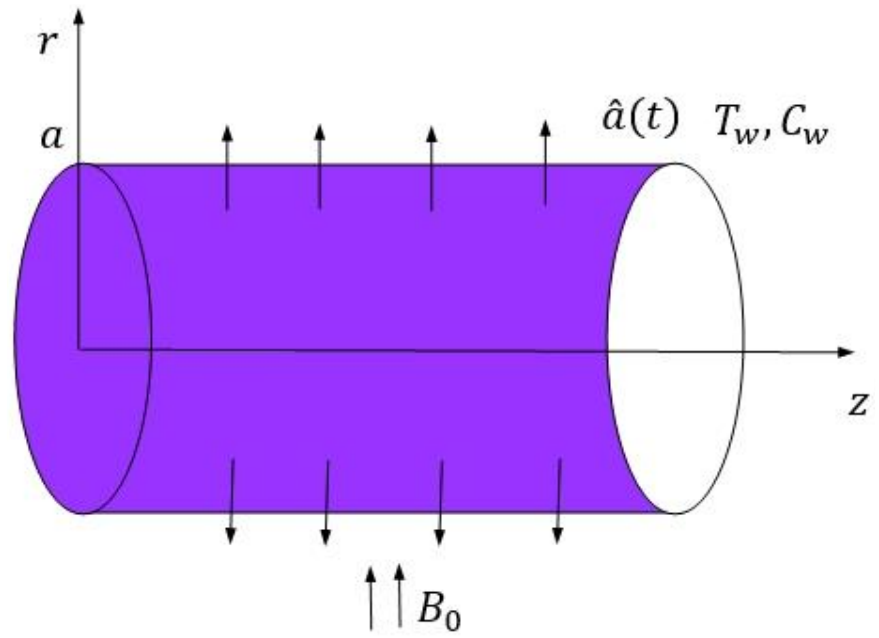
Figure 1. Geometrical presentation of the problem.